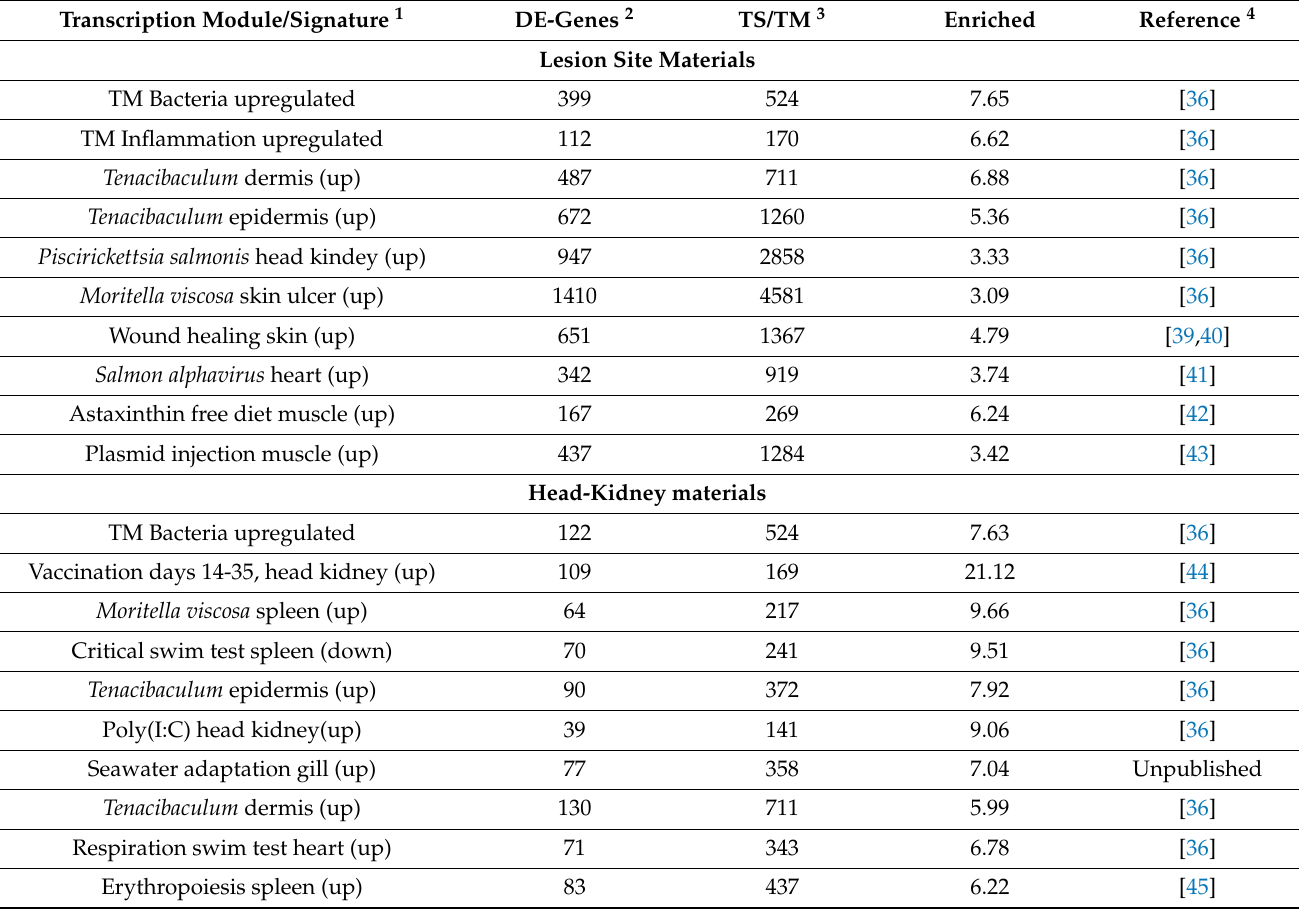
Table 5. Highly enriched TM and TS classifications among differentially expressed genes identified by microarray in Lesion Site and Head-Kidney